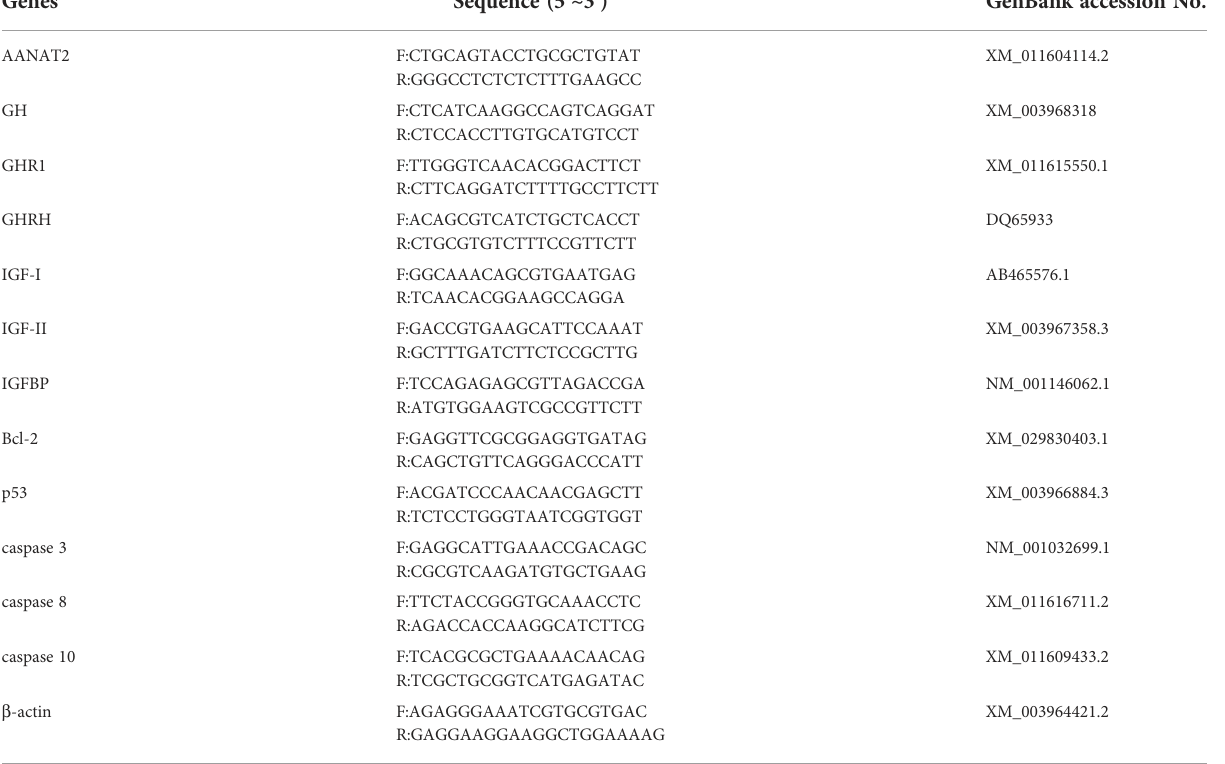
TABLE 1 The sequences of primers for real-time PCR.